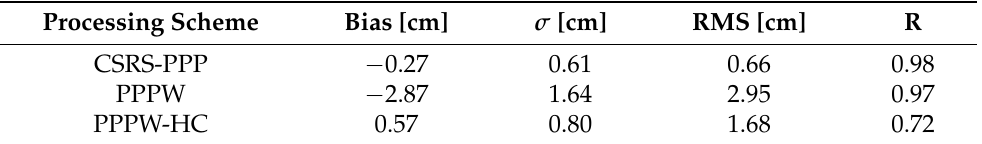
Table 8. Performance metrics for the ZTD validation against ERA-ZTD for processing results of CSRS-PPP, PPPW and PPPW-HC for CS2.